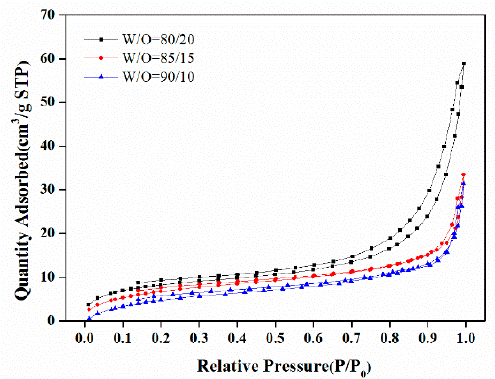
Figure 4. N 2 adsorption-desorption curves of the polyHIPE scaffolds fabricated with different W/O ratio.